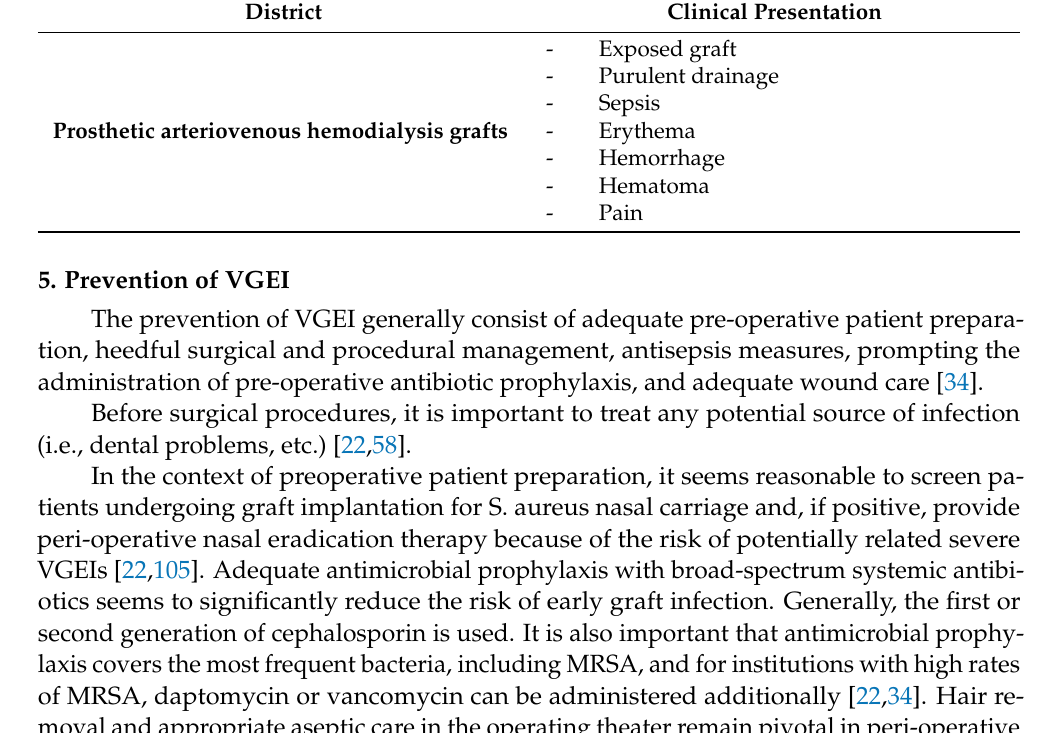
Table 2. Cont. District Clinical